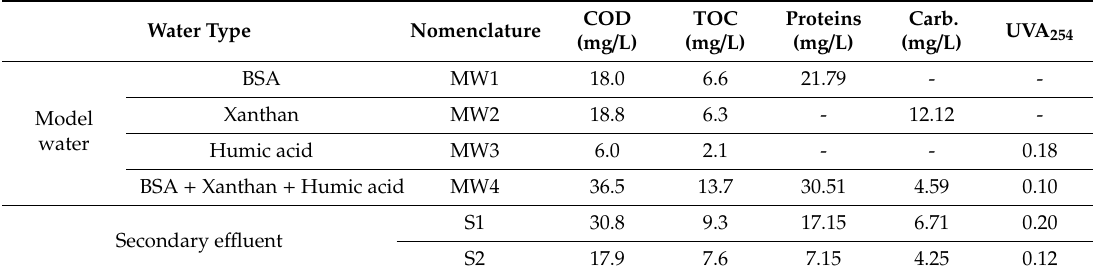
Table 1 details the characteristics of model solutions and wastewater samples used in this work. UVA 254 is the absorbance at 254 nanometers of wave length. Table 1. Model waters and wastewater nomenclature and